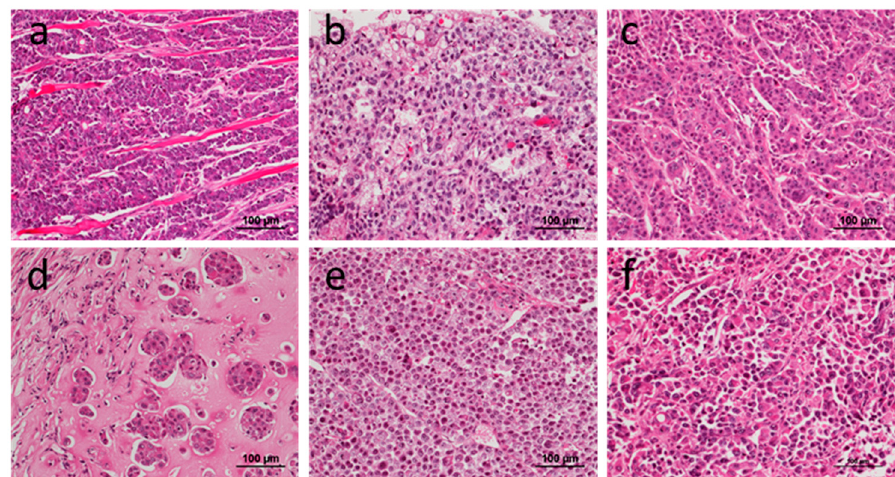
Figure 4. Histology of six CDXs from CART cases ( a – f ). All tumors were of the poorly differentiated adenocarcinoma phenotype.